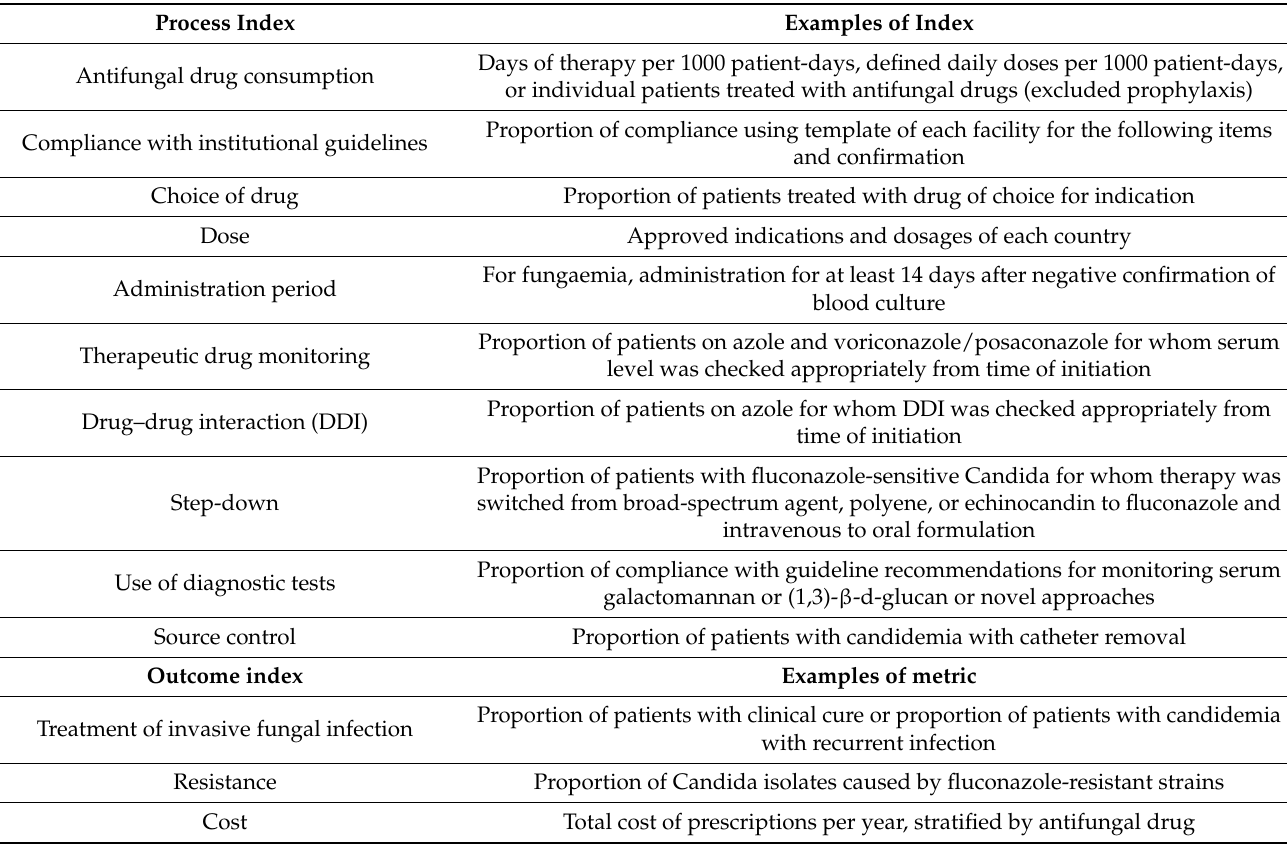
Table 1. Suggestions for process and outcome indices for antifungal stewardship by